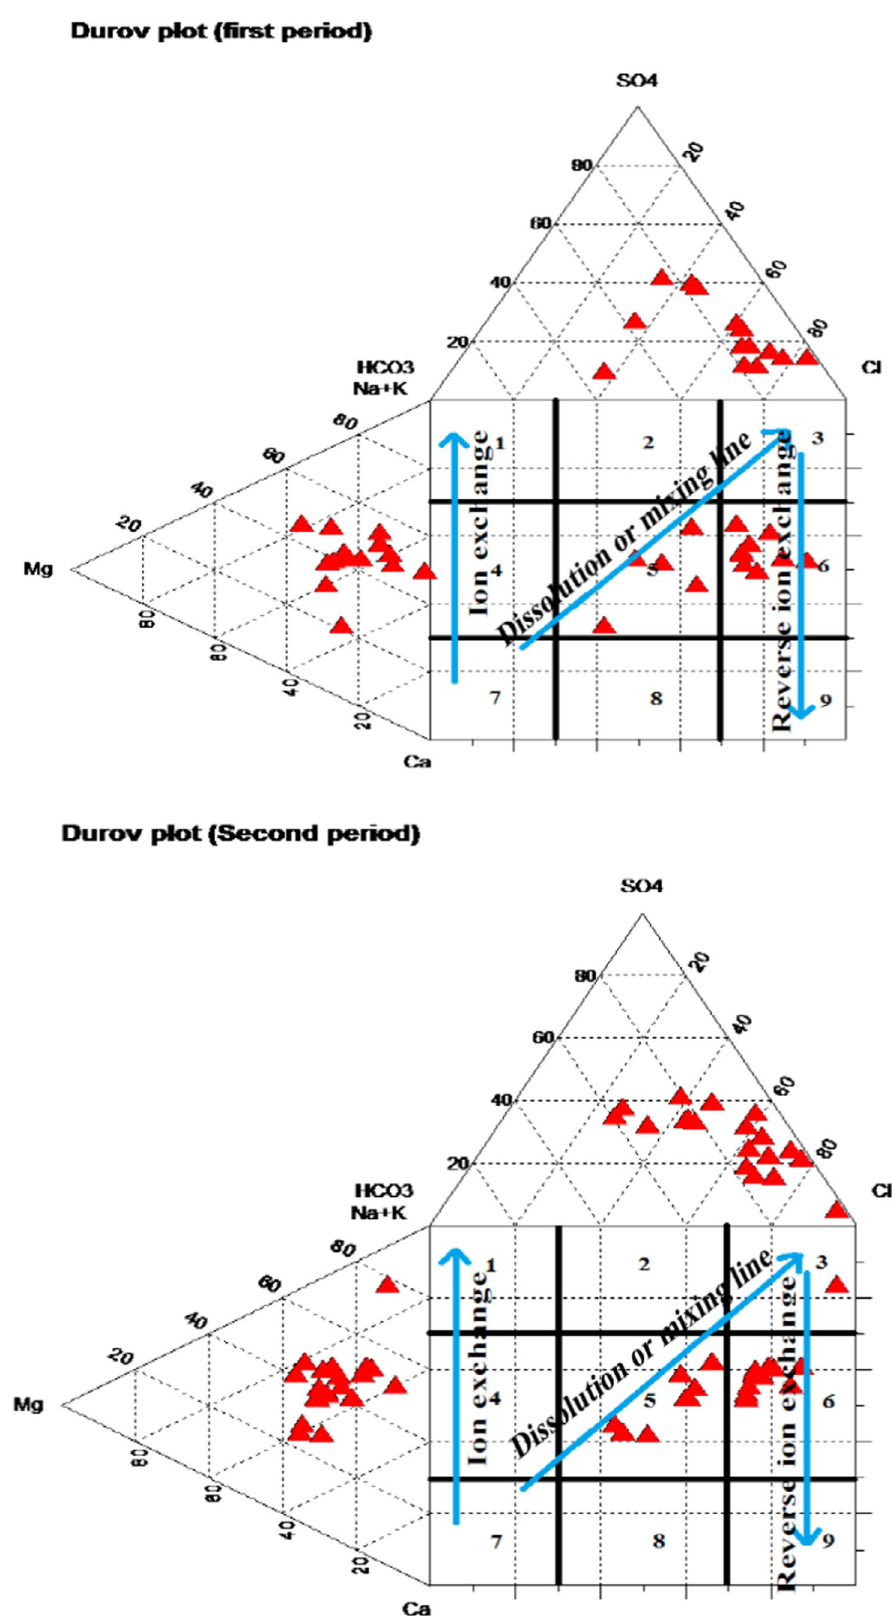
Fig. 8 Durov diagram depicting hydrochemical processes for groundwater samples